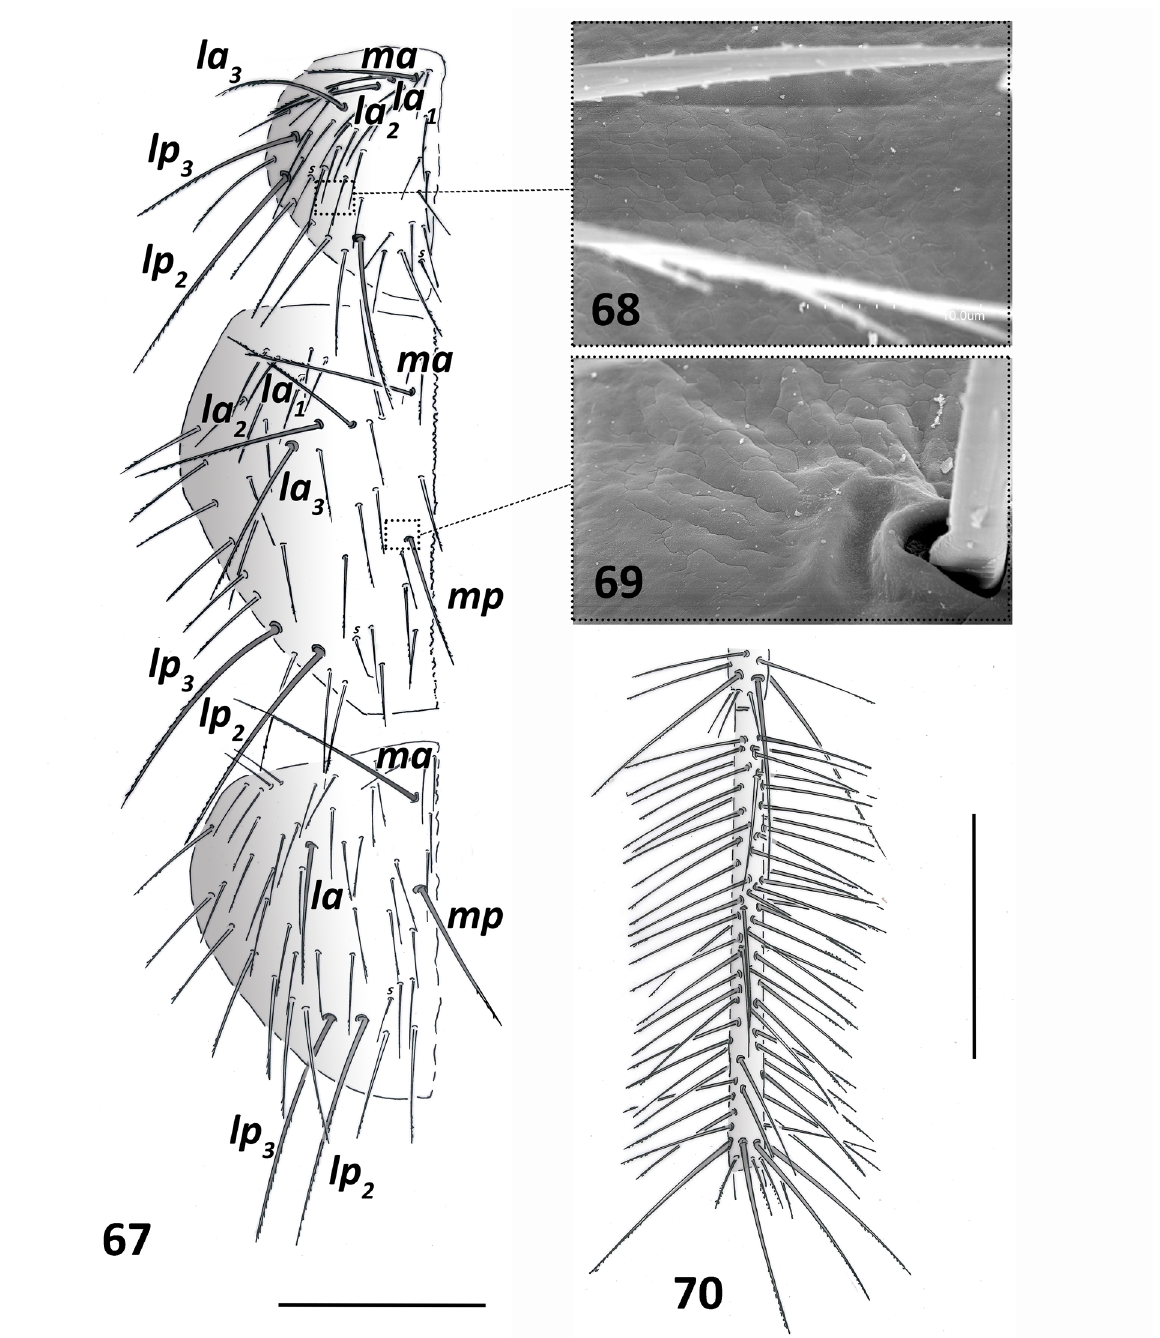
Figs 67–70. Plusiocampa ( Plusiocampa ) hoffmanni Sendra & Paragamian sp. nov. 67, 70 . Paratype, ♂, 5.4 mm long, from Spilaio Doxa, Marathos, Irakleo Prefecture, Crete (MZB). 68–69 . Specimen from Varathro Mythia Kabathoura, Rethymno, Crete (Coll. AS). 67 . Pronotum, mesonotum and metanotum, left side. 68 . Surface of pronotum. 69 . Surface of mesonotum. 70 . Fourth cercal article. Scale bars: 67 = 0.4 mm; 70 = 0.5